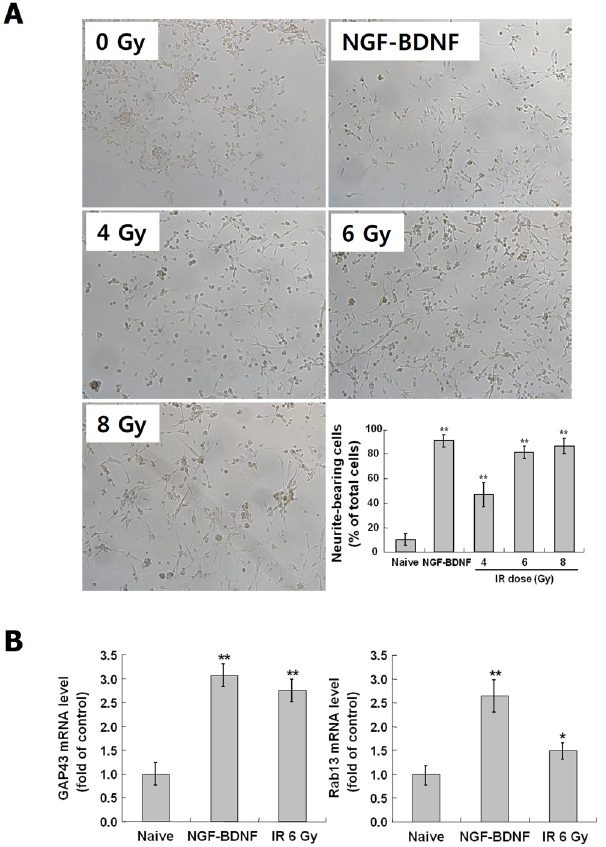
Fig 1. Induction of neurite outgrowth and the related genes by IR in C17.2 cells. C17.2 cells were exposed to IR at 4, 6 and 8 Gy or treated with NGF and BDNF at 20 ng/ml, and incubated at 37°C for 72 hr. The morphological change for neurite outgrowth by IR was observed in microscopic images (×200 magnification) (A). To assess rate of neurite-bearing cells, each 200 cells in three randomly taken images were analyzed by Image J software (A, right-down panel). To confirm IR-induced mRNA expression of neurite outgrowth-related genes, GAP43 and Rab13, irradiated Neuro-2a cells were analyzed by real-time PCR (B). The results represent the mean ± SD from triplicate data. * p < 0.05, ** p < 0.01 vs naive